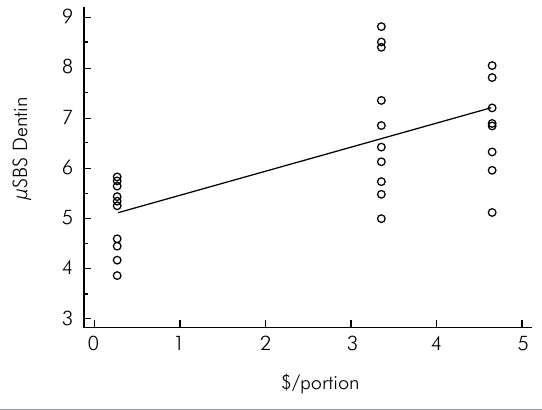
Figure 6. Linear regression: cost versus